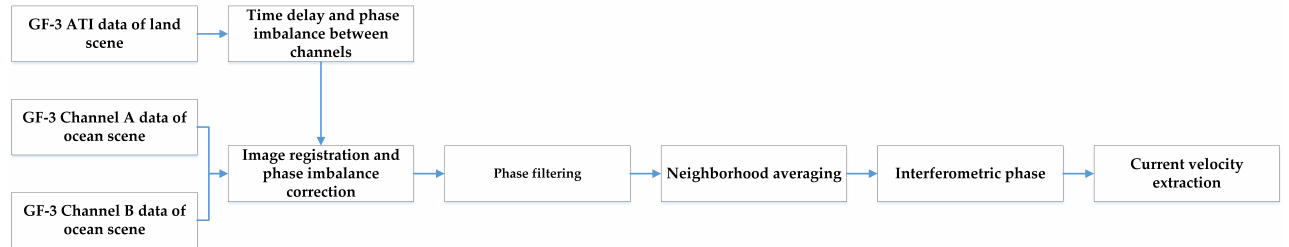
Figure 14. GF-3 ATI data procession flow diagram.